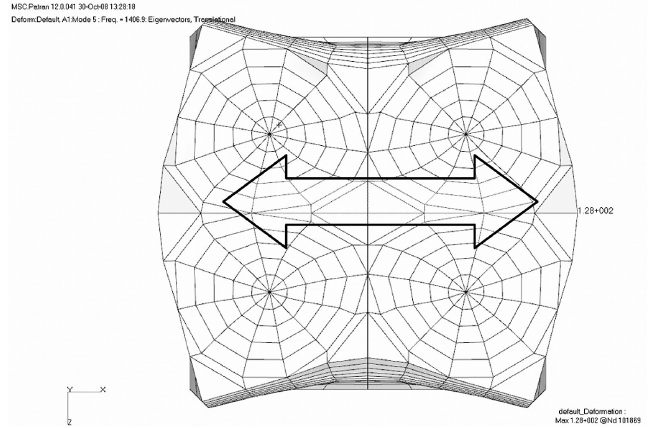
Fig. 18. 5th mode: 1407 Hz.